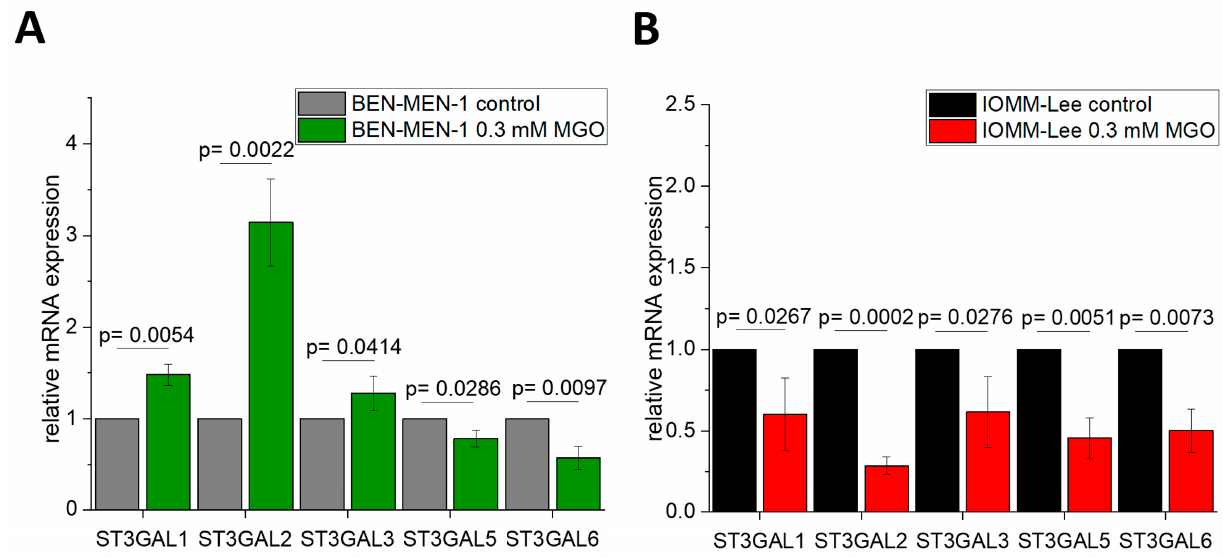
Figure 3. Relative mRNA expression of ST3GAL1–6 in BEN-MEN-1 ( A ) and IOMM-Lee ( B ). ( A ): Normalized control (grey) and mRNA expression after 24 h treatment with 0.3 mM MGO (green). ( B ): Normalized control (black) and mRNA expression after 24 h treatment with 0.3 mM MGO (red). Statistical analysis was performed using t -test and error bars represent SD (n = 4; ( ST3GAL1 : p = 0.0054 ( A ), p = 0.0267 ( B ); ST3GAL2 : p = 0.0022 ( A ), p = 0.0002 ( B ); ST3GAL3 : p = 0.0414 ( A ), p = 0.0276 ( B ); ST3GAL5 : p = 0.0286 ( A ), p = 0.0051 ( B ); ST3GAL6 : p = 0.0097 ( A ), p = 0.0073 ( B )).